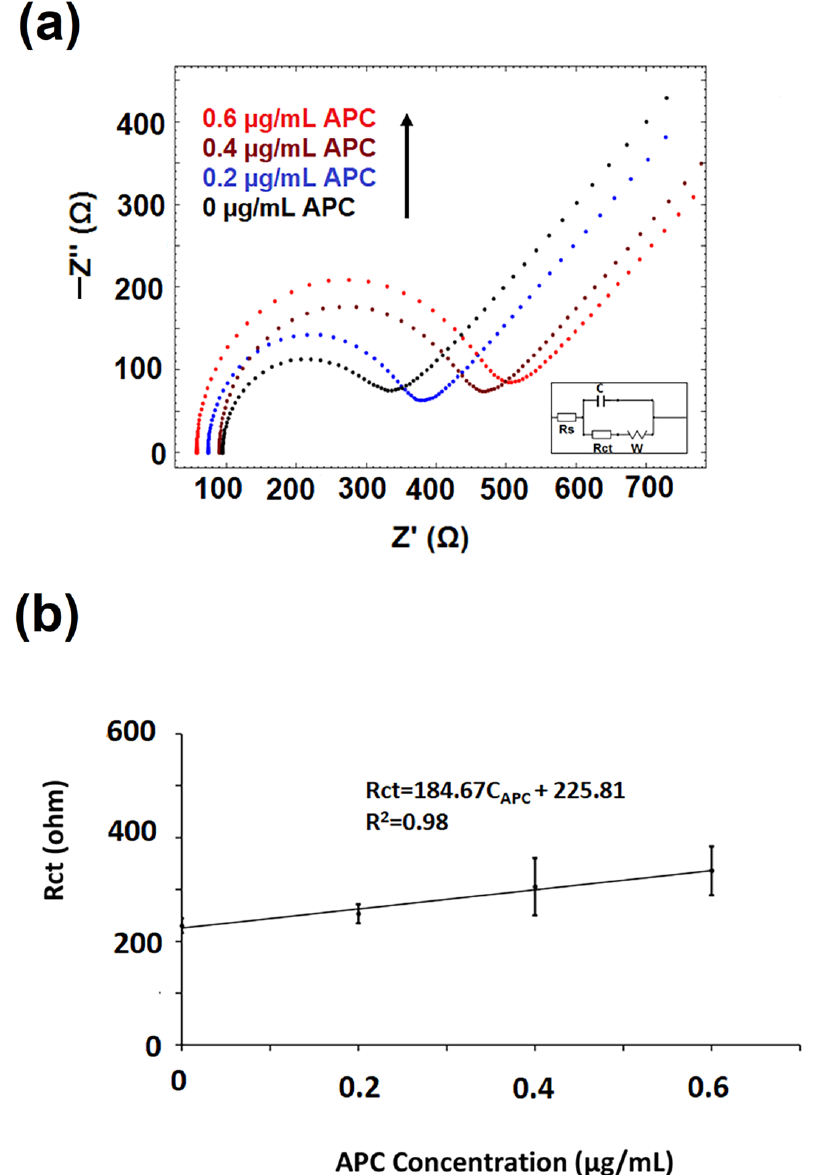
Figure 6. ( a ) Nyquist diagrams representing the response of aptasensor in different concentrations of APC in the medium of 1:2000 diluted FBS. ( b ) Calibration curve presenting the data for impedimetric determination of APC in 1:2000 diluted FBS.